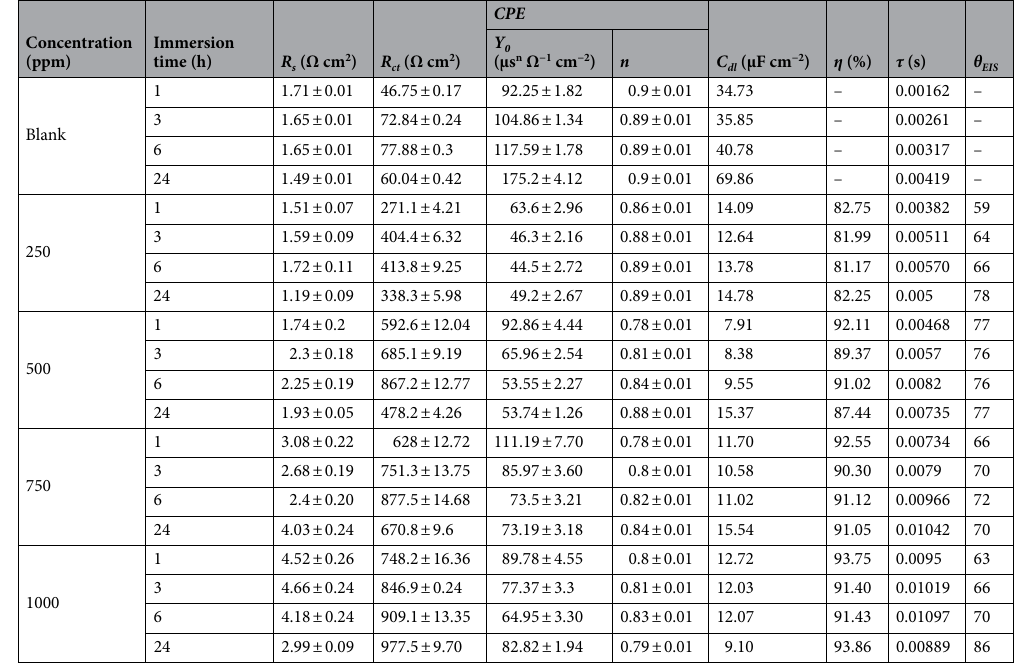
Table 2. EIS parameters of MS in the presence of different concentrations of DPH in 1 M HCl